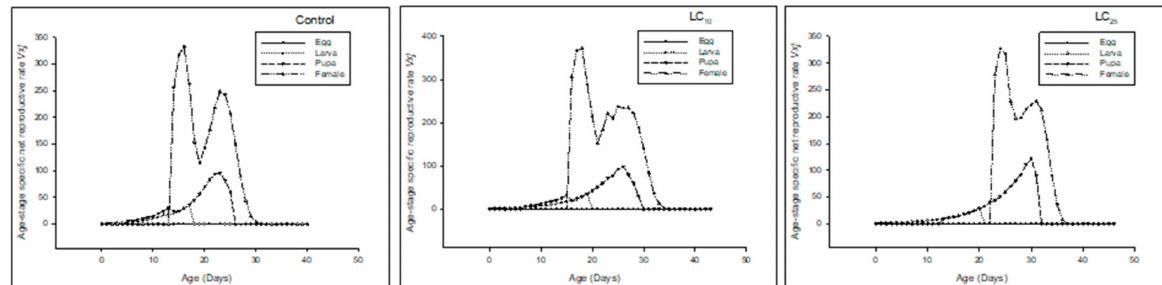
Figure 9. Age stage-specific reproductive rate ( v xj ) of the F 2 generation in Spodoptera frugiperda